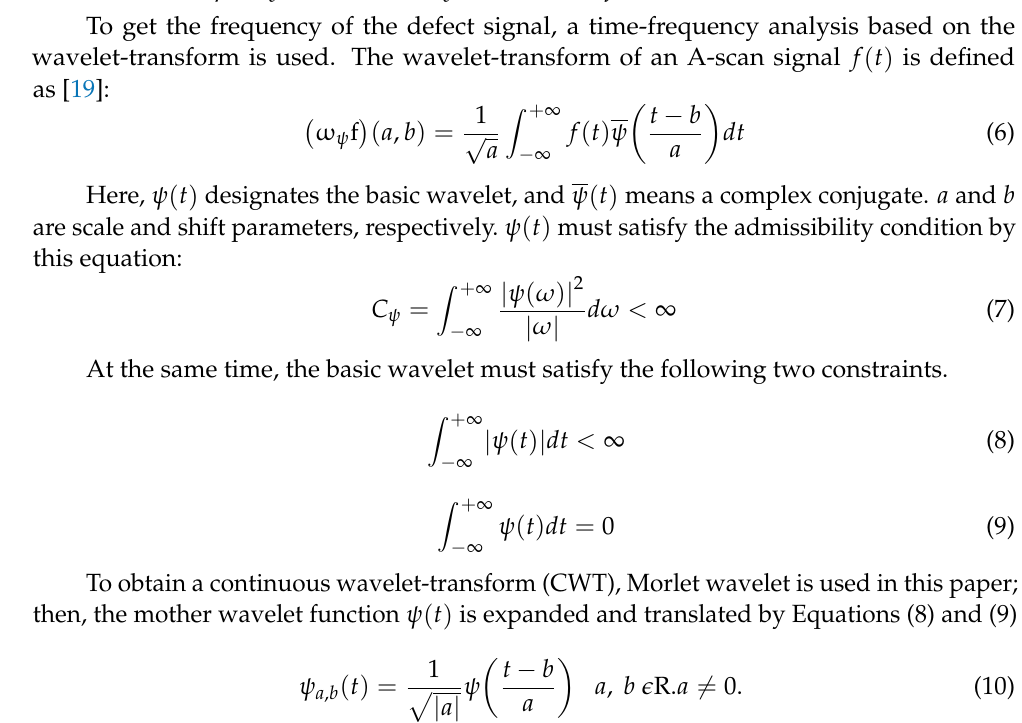
0 mode velocity dispersion